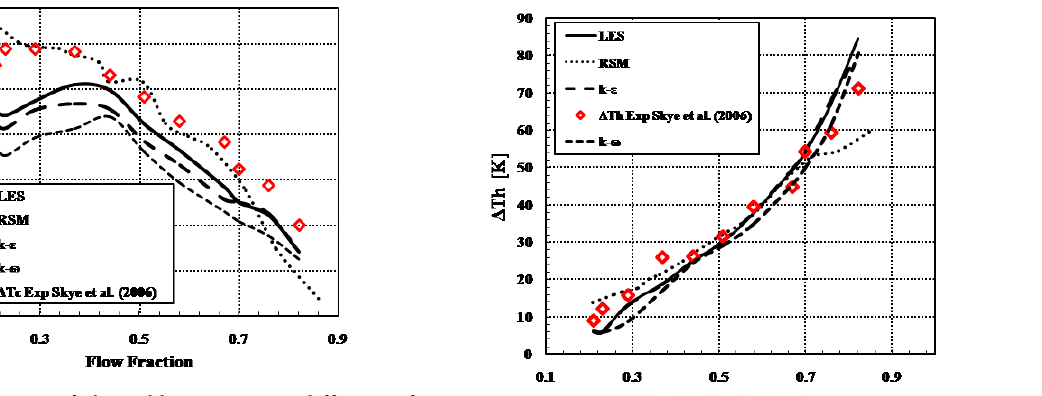
Fig. 14. Variation of the cold temperature difference for different types of operating turbulence models as a function of the cold flow fraction (compared with experimental results)